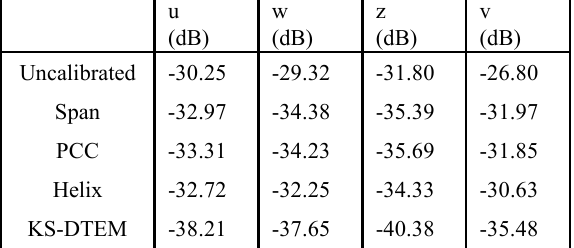
Table 1 . Crosstalk accuracy for different extraction methods